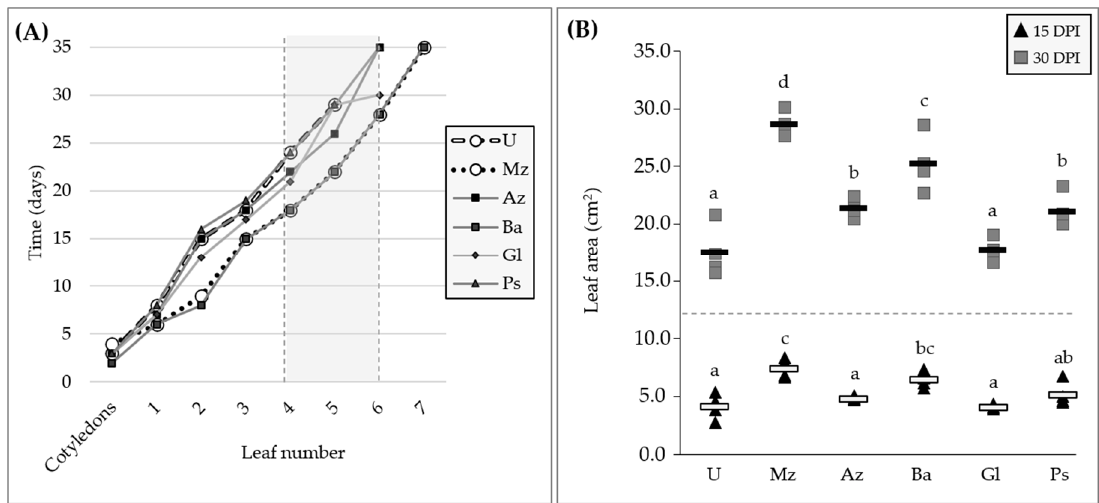
Figure 4. ( A ) Variation in number of leaves as a function of time in days post-inoculation and ( B ) leaf area 14 and 30 days post-inoculation (DPI) with each bio-input in lettuce seedlings. In the figure, average of days after which new leaves appear ( A ) and leaf area ( B ) are plotted. Different letters in the statistical data analysis (on the right) indicate significant differences ( p ≤ 0.05) according to Tukey’s test. Mz: multispecies; Az: A. argentinense Az39; Ba: Bacillus sp. Dm-B10; Gl: G. diazotrophicus PAL5; Ps: P. protegens Pf5; U: uninoculated.